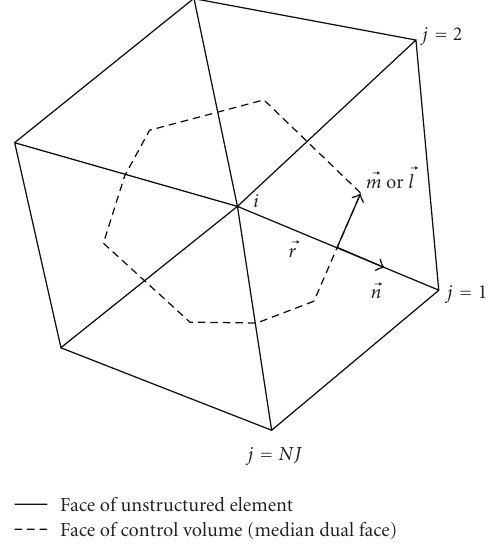
Figure 4: Control volumes are defined as median duals surround- ing each